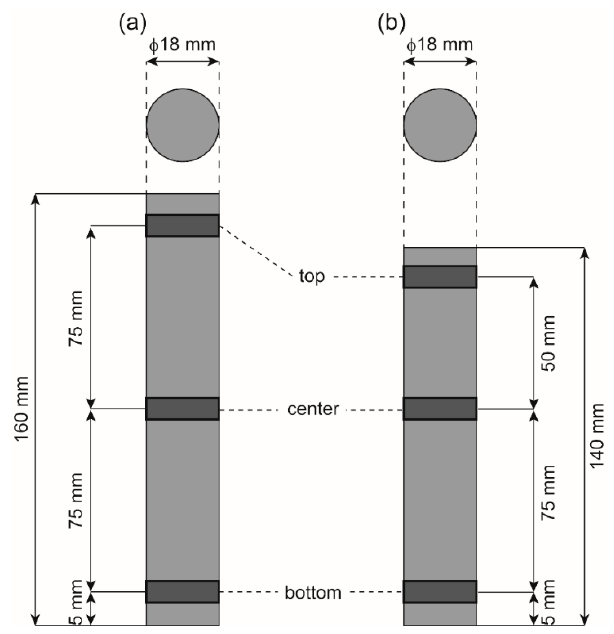
Figure 1. Schematics of as-built bar specimens used in this study: ( a ) high-C and ( b ) low-C alloys.